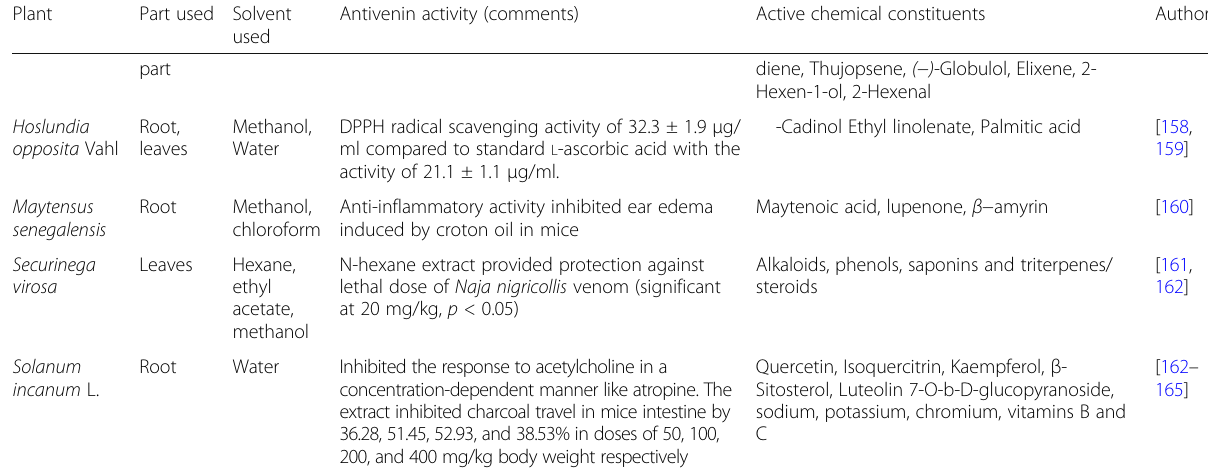
Table 3 Antivenin activities of some plants used for snakebite treatment in Uganda as per global reports (Continued) Plant Part used Solvent